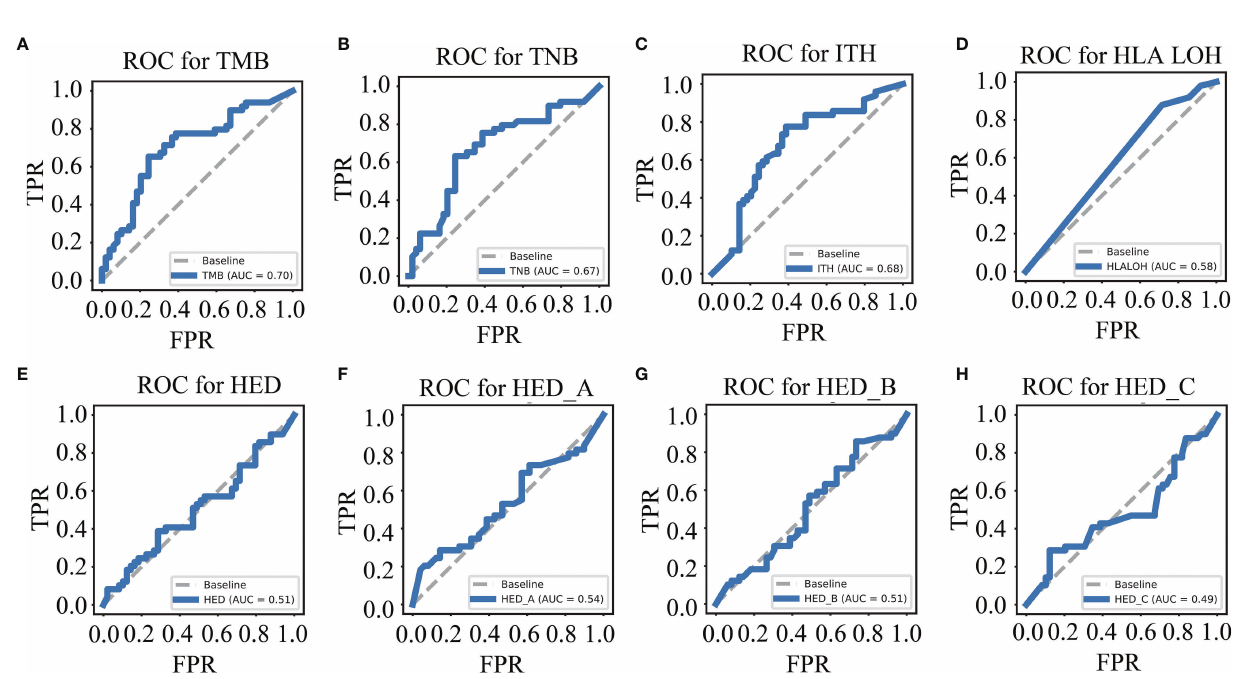
FIGURE 1 | Single biomarker has limited ability to distinguish the responders from the non-responders. ROC curves for TMB (A) , TNB (B) , ITH (C) , HLA LOH (D) , HED (E) , HED_A (F) , HED_B (G) , and HED_C (H) in the training cohort. TMB, tumor mutation burden; ITH, intratumoral heterogeneity; HLA LOH, loss of heterozygosity in human leukocyte antigen; HFD, HLA-I evolutionary divergence; ROC, receiver operating